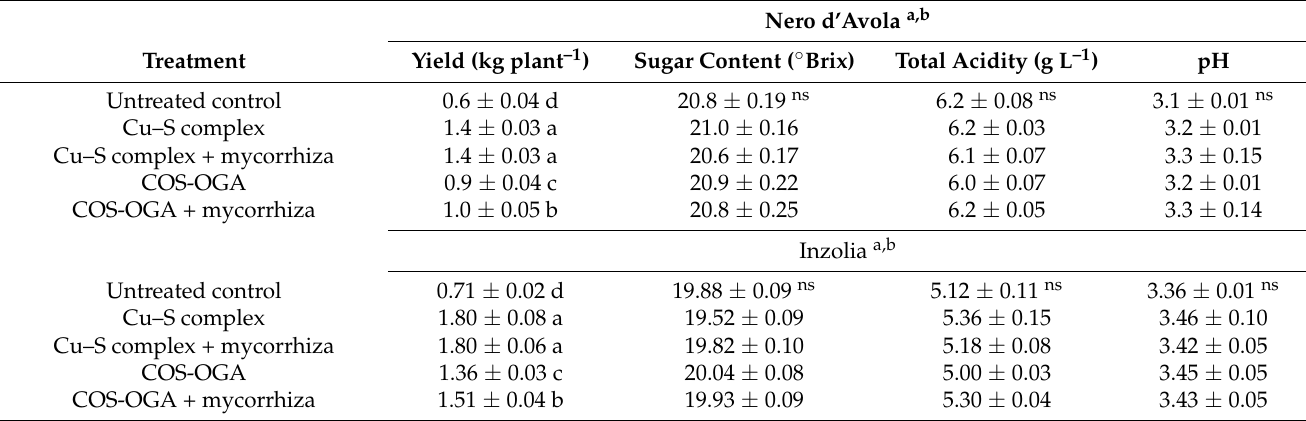
Table 7. Grape production and oenological parameters of Nero d’Avola and Inzolia. Nero d’Avola